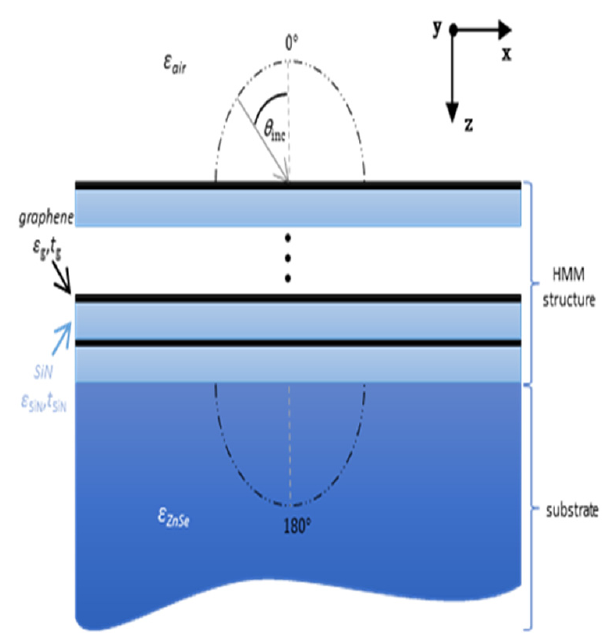
Figure 2. Schematic of the proposed optical diode (optical isolator).